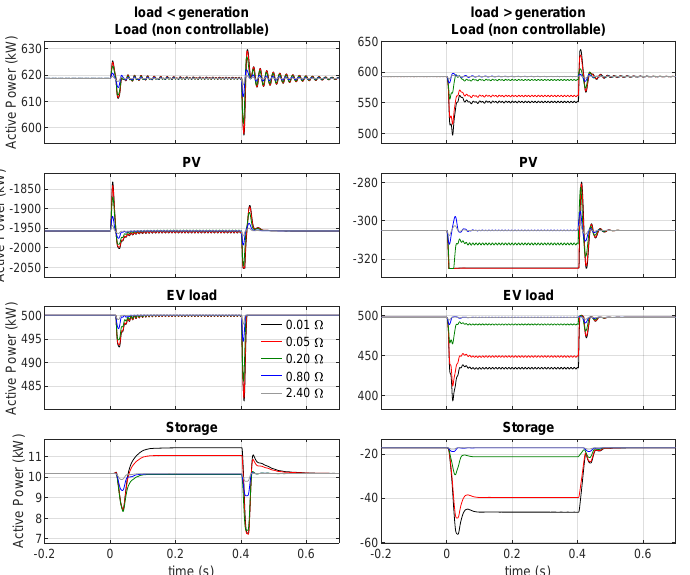
Figure 28. Active power per type of resources connected to the ST’s hybrid AC/DC network following unbalanced phase-ground faults in the HV AC grid for the considered fault